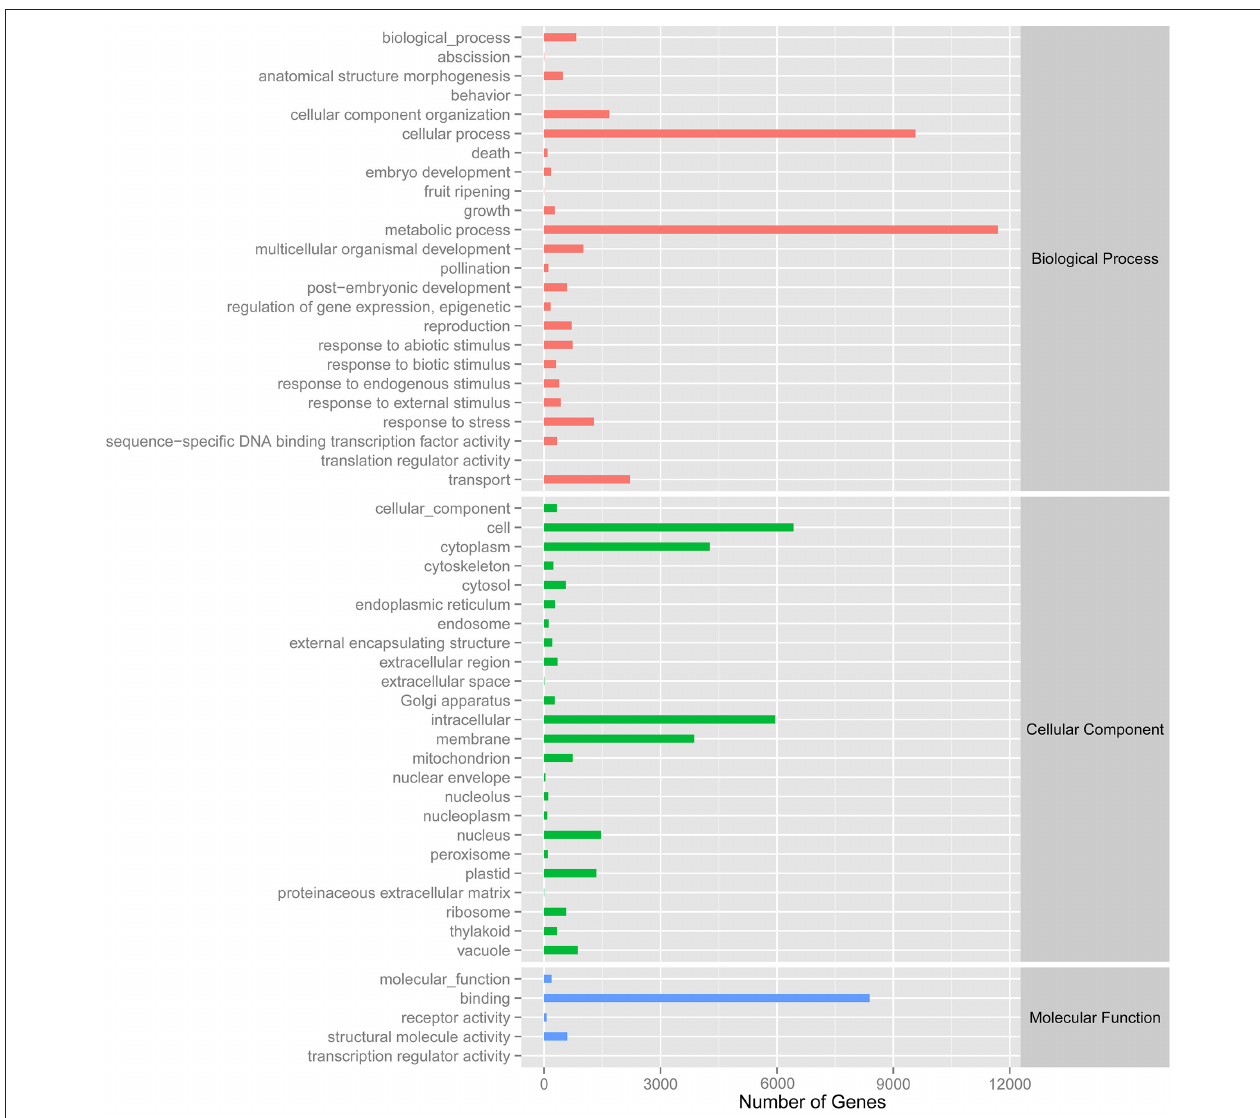
FIGURE 2 | Number distribution of GOSlim annotation of Unigenes related to biological process, cellular component and molecular function.